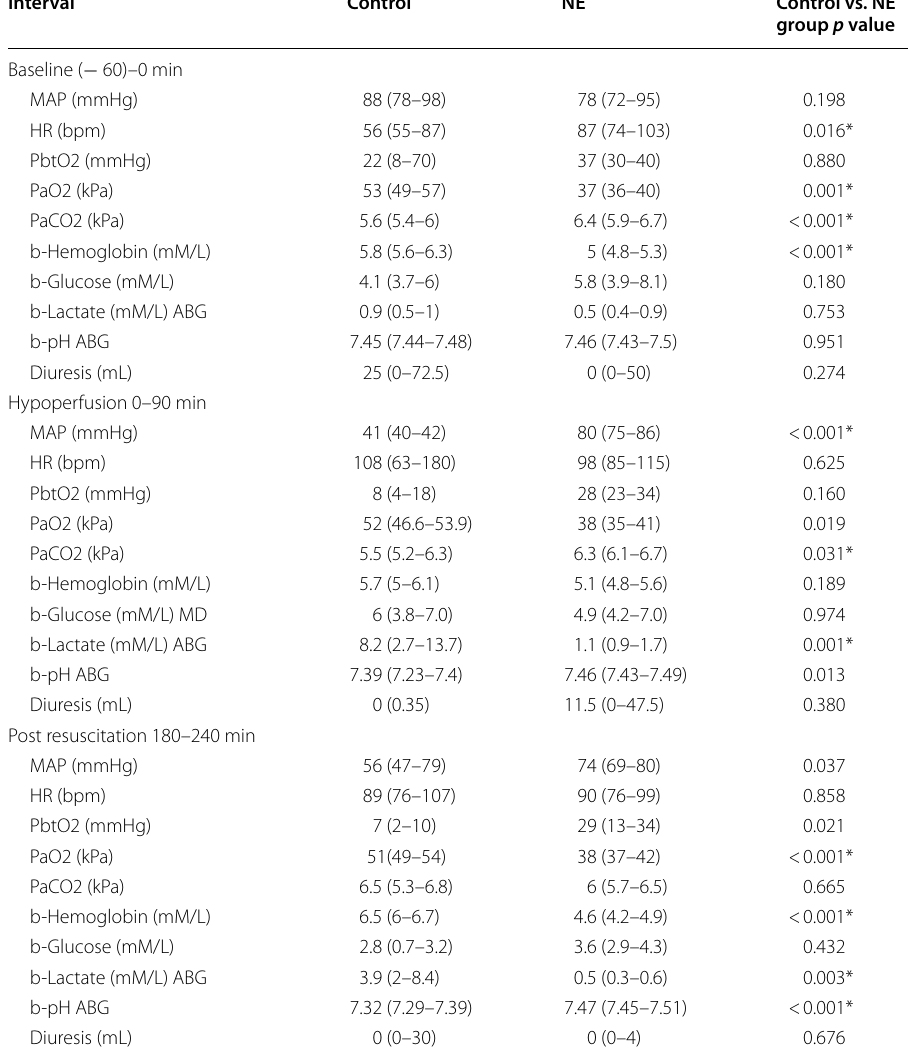
Table 1 General physiological haemodynamic and systemic parameters for baseline, hypoperfusion and post resuscitation